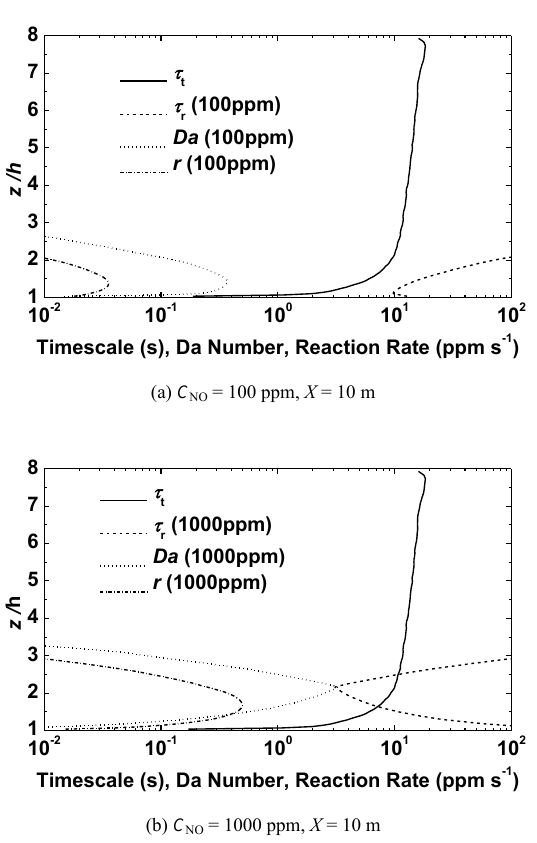
Figure 2. Vertical profiles of turbulent timescale τ t , reaction timescale τ r , Damköhler number Da and reaction rate r (averaged in streamwise and spanwise directions)